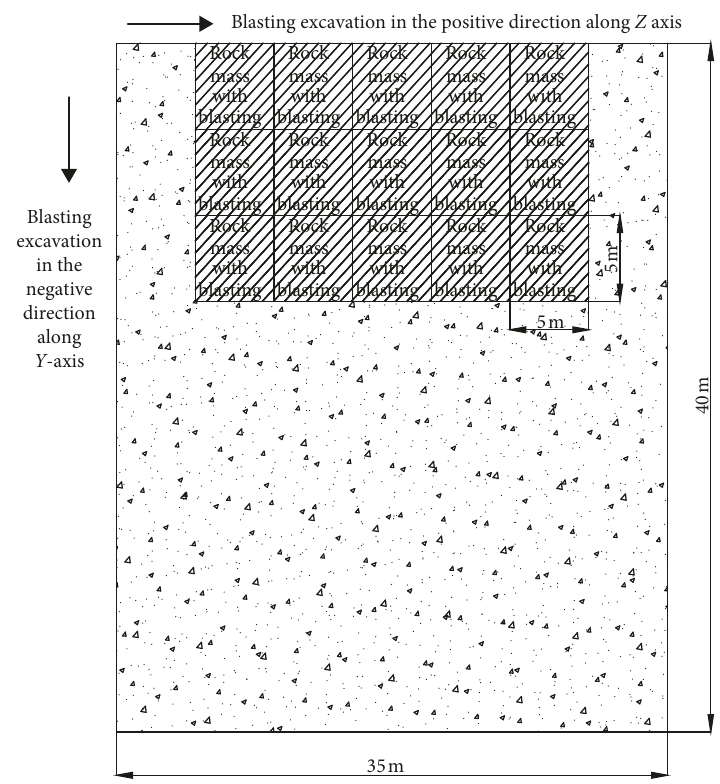
Figure 5: Schematic diagram of stratified partition excavation in the baseboard of the numerical